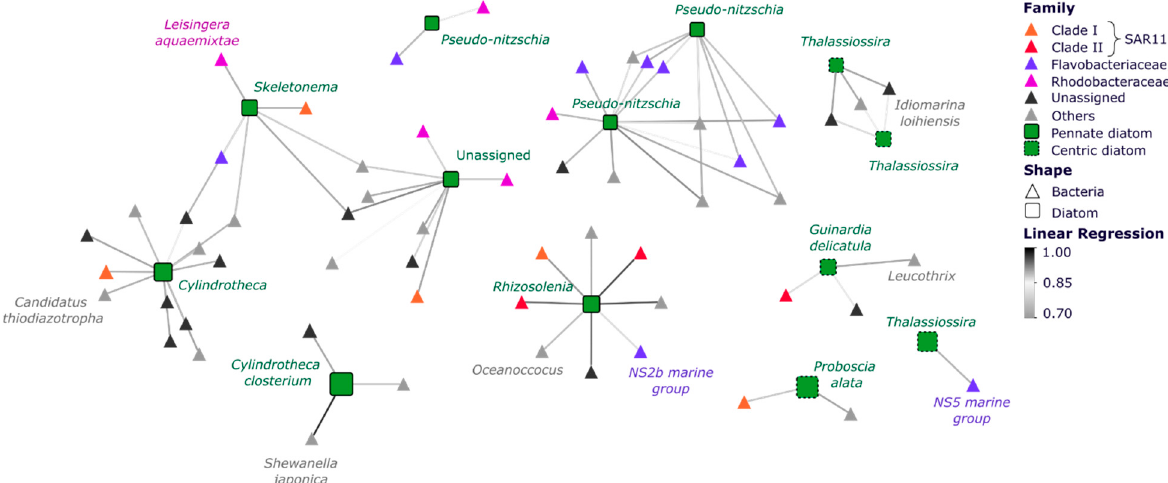
Figure 7. Co-occurrence Networks Subset of Diatoms and Bacteria. Correlations are based on MINE analysis and show only statistically significant positive correlations between diatom and